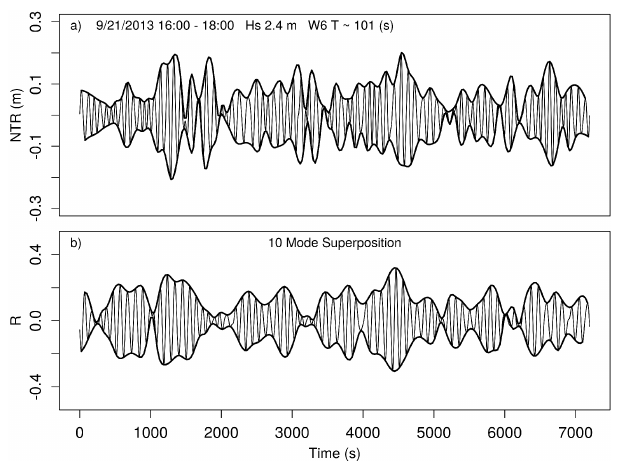
Figure 11. (a) Wavelet level W 6 of the nontide residual over a 2h period on 21 September 2013 when offshore wave height was 2.4m. (b) Time series reconstruction from ten spectral amplitudes of Fig. 6